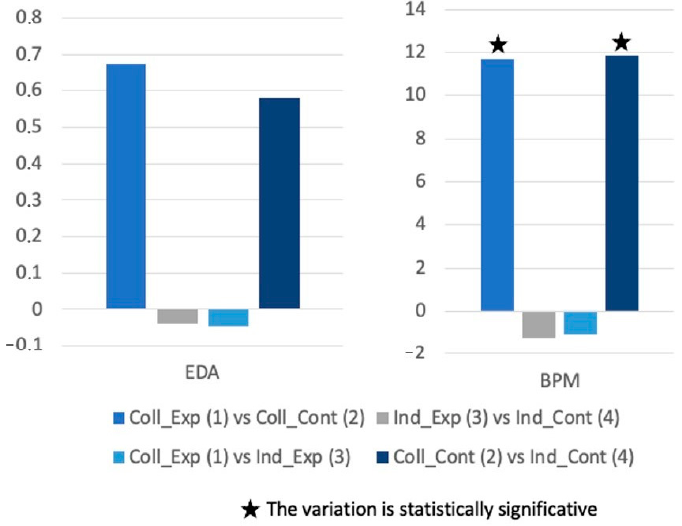
Figure 8. Graph of the variation estimates for the physiological variables and their statistical signifi- cance ( p <